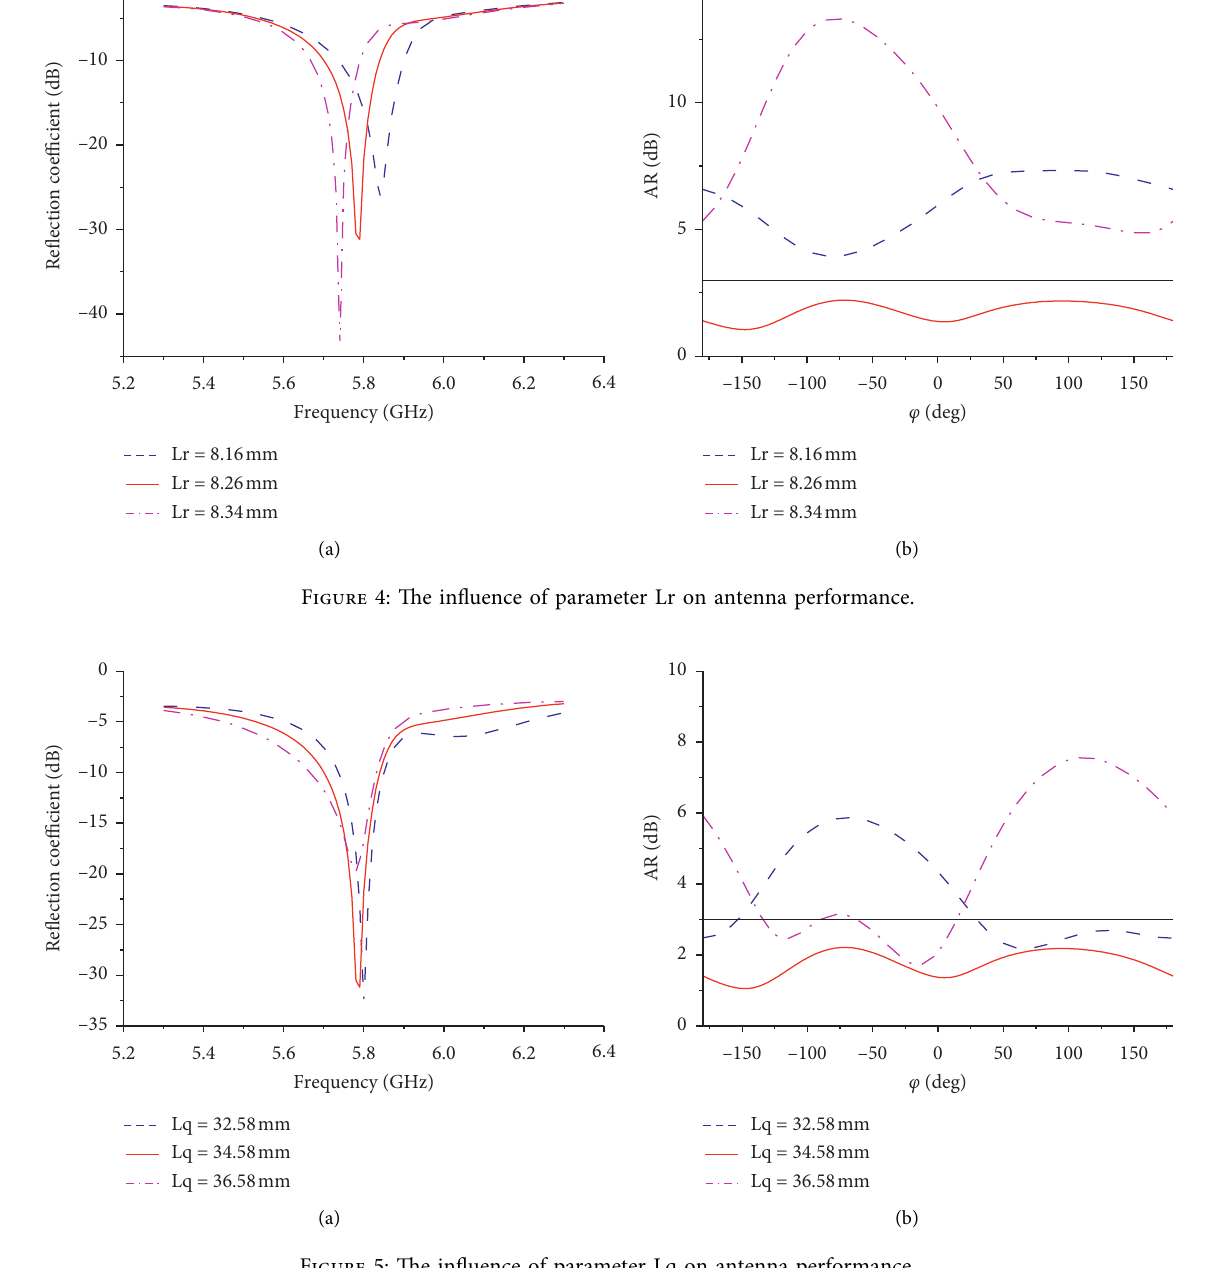
Figure 5: The influence of parameter Lq on antenna performance.